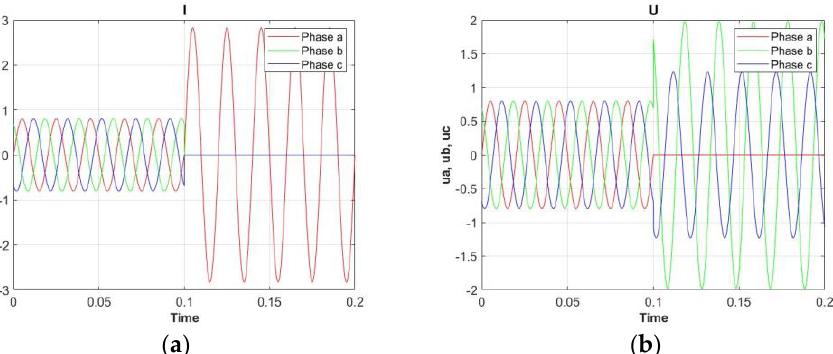
Figure 3. Images of changes in signals of corresponding ( a ) currents and ( b ) voltages during a short circuit in phase a.